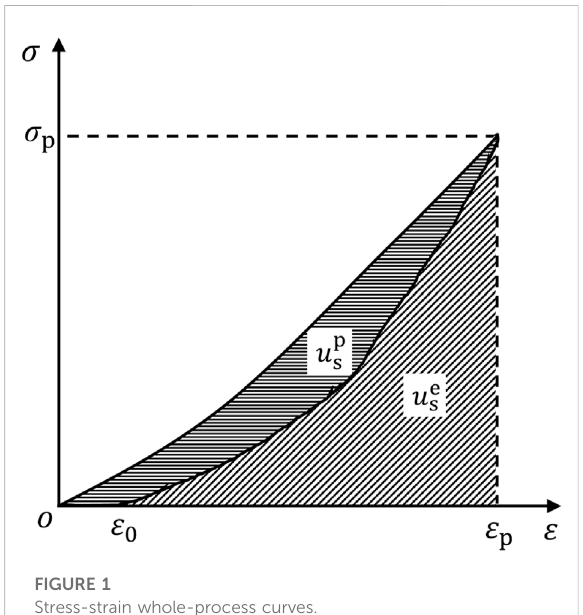
FIGURE 1 Stress-strain whole-process